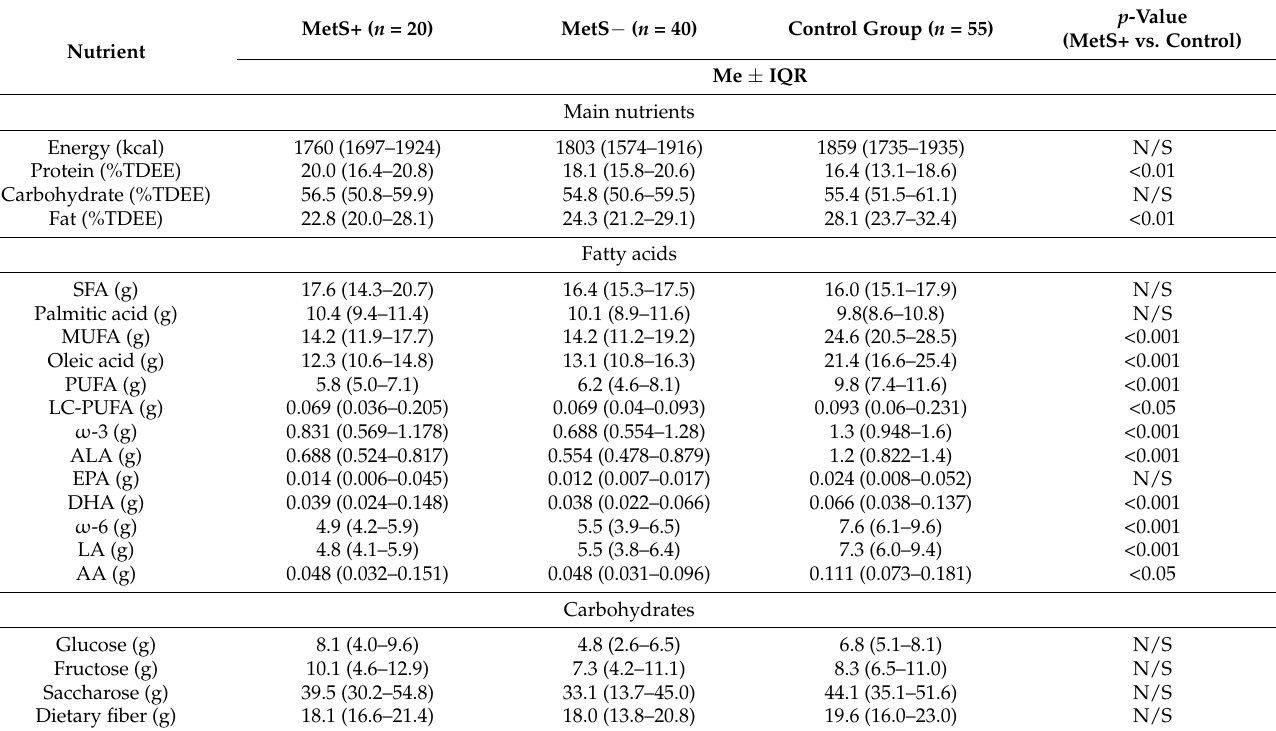
Table 7. Consumption of selected nutrients with the